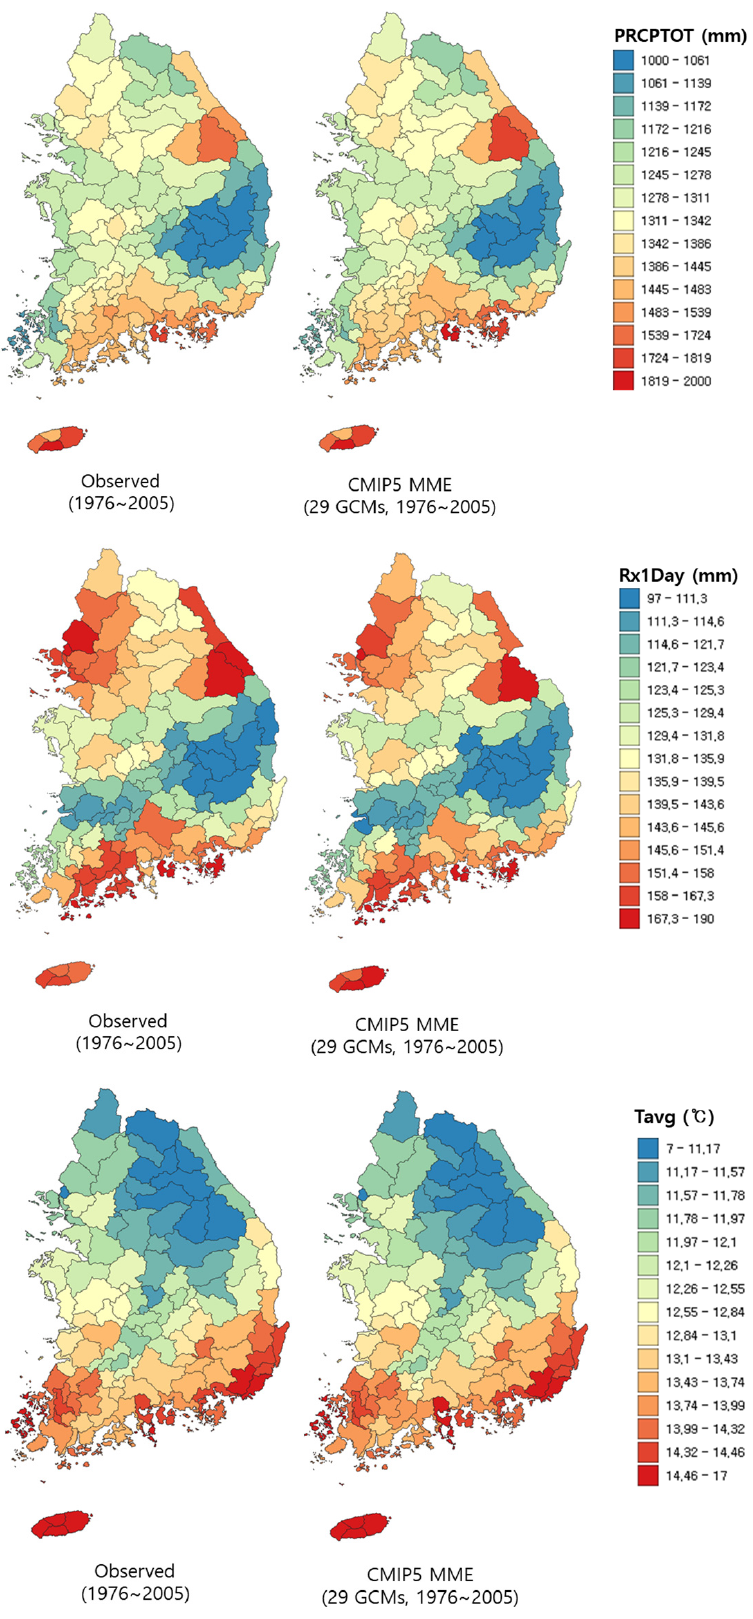
Figure 3. Spatial patterns of annual total precipitation (PRCPTOT), max 1-day precipitation and annual average temperature (Rx1day), and annual average temperature (Tavg).